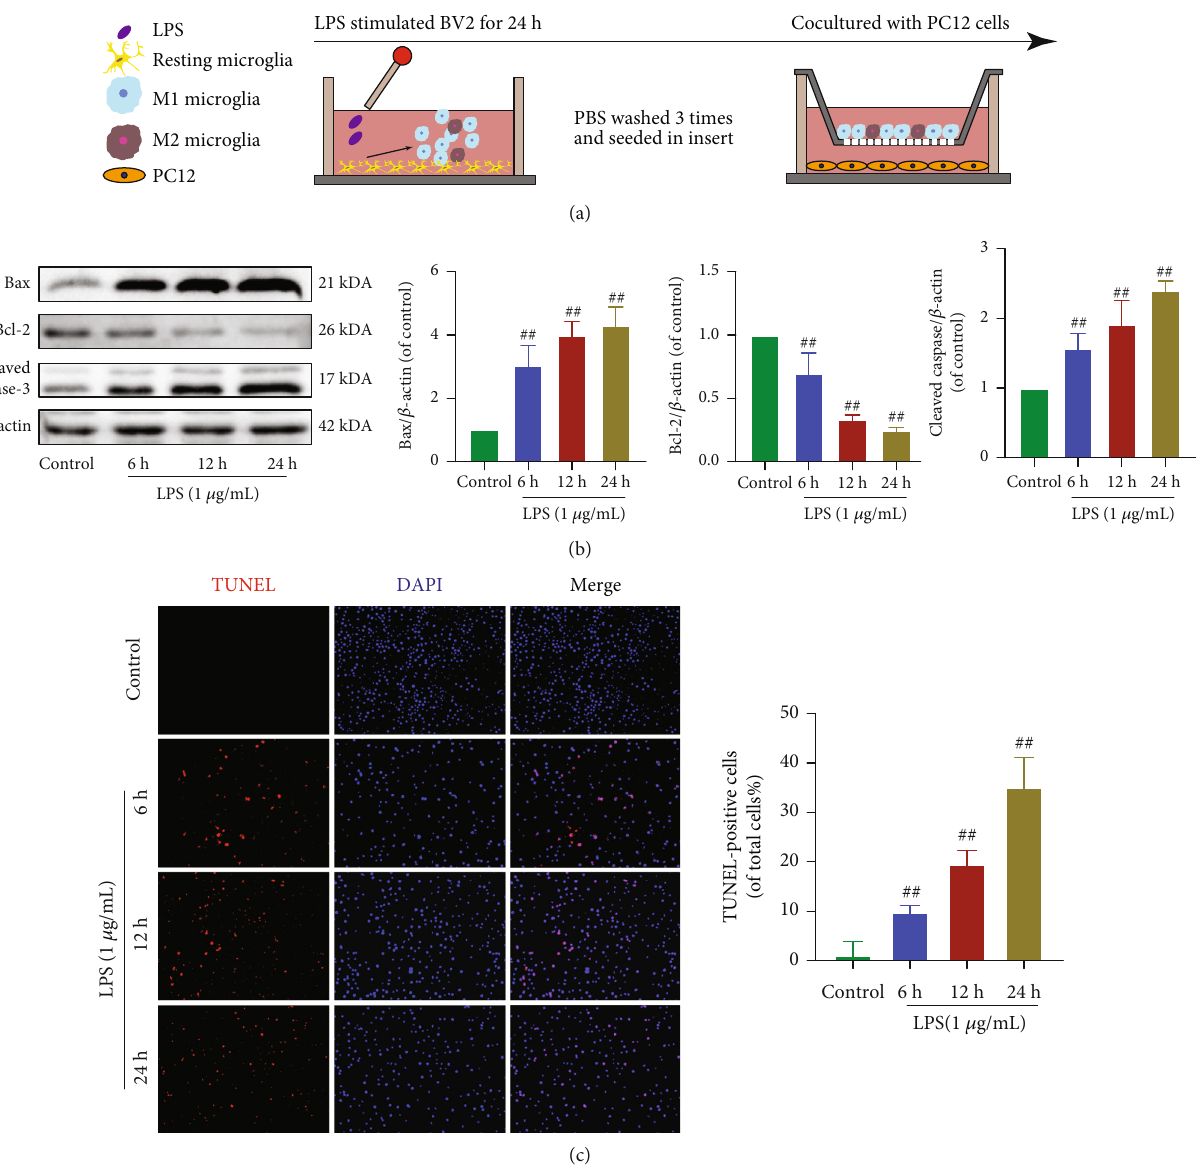
Figure 8: E ff ect of M1 microglia on neuronal apoptosis. (a) Schematic of cell treatments. (b) Representative WB and quantitative data of apoptosis-related proteins. (c) Apoptosis of PC12 was detected by TUNEL (scale bar: 200 μ m). ## p < 0 : 01 vs. control